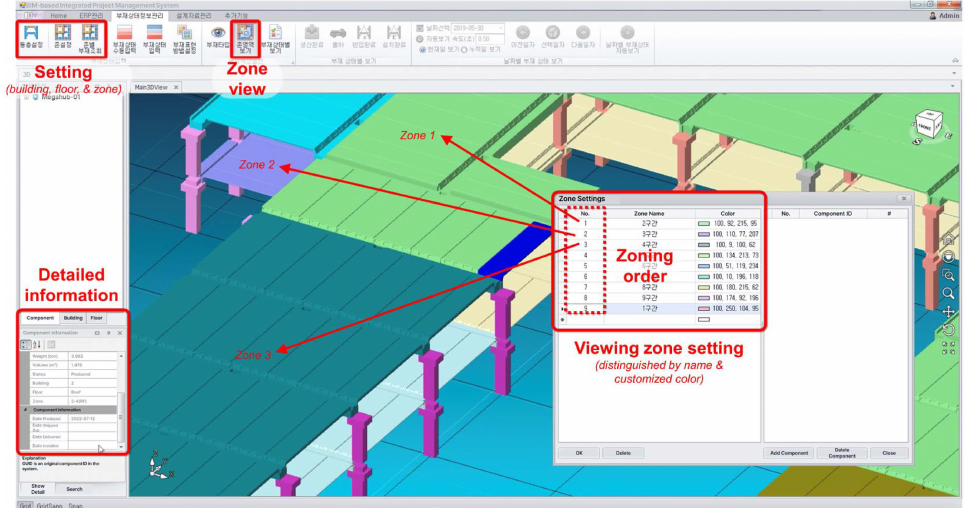
Figure 4. UI for project zone